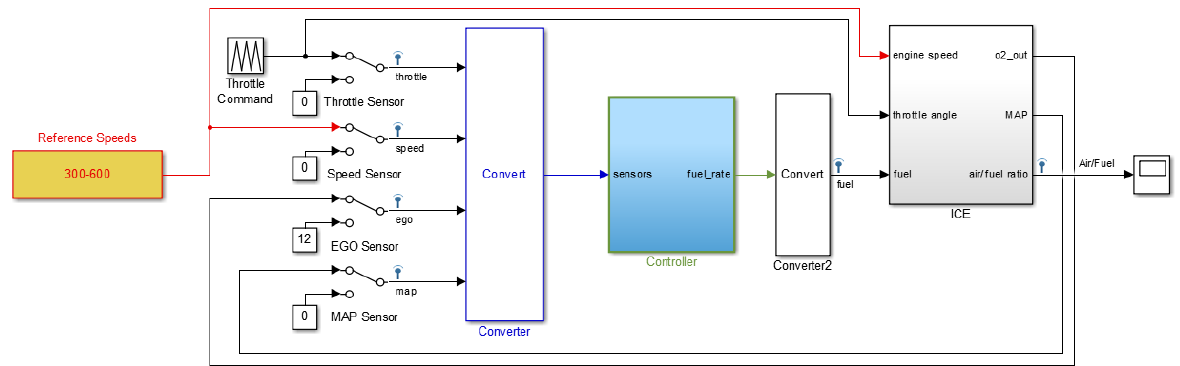
Figure 2. Collecting data from a system with sensors in normal and abnormal conditions.